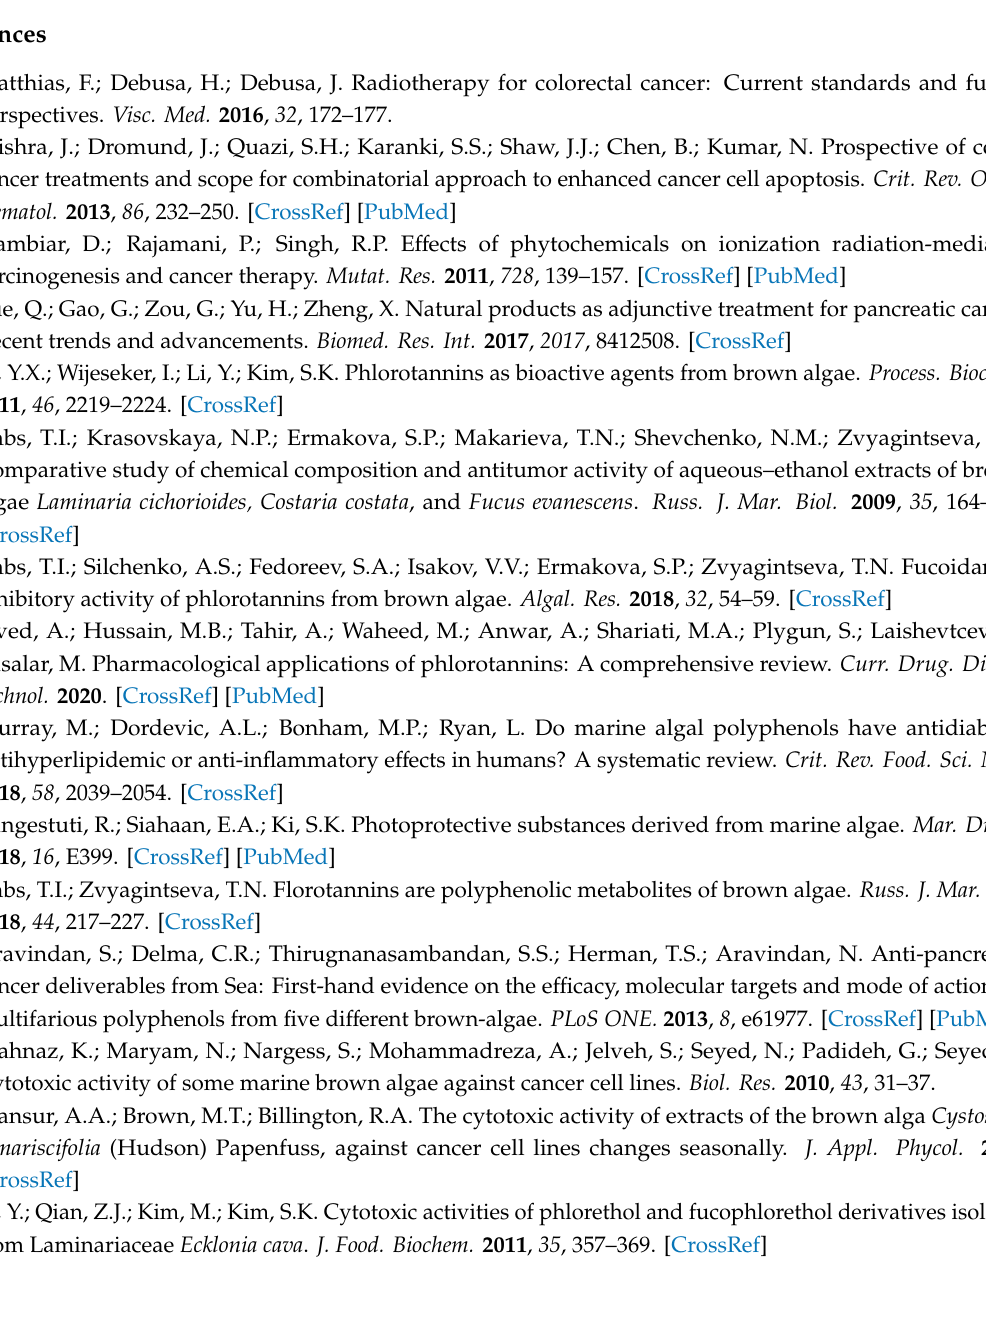
Supplementary Materials: The following are available online, Figure S1: 13 C-NMR spectra of the CcPh fraction, Figure S2: HMBC NMR spectra of the CcPh fraction, Figure S3: HSQC NMR spectra of the CcPh fraction,